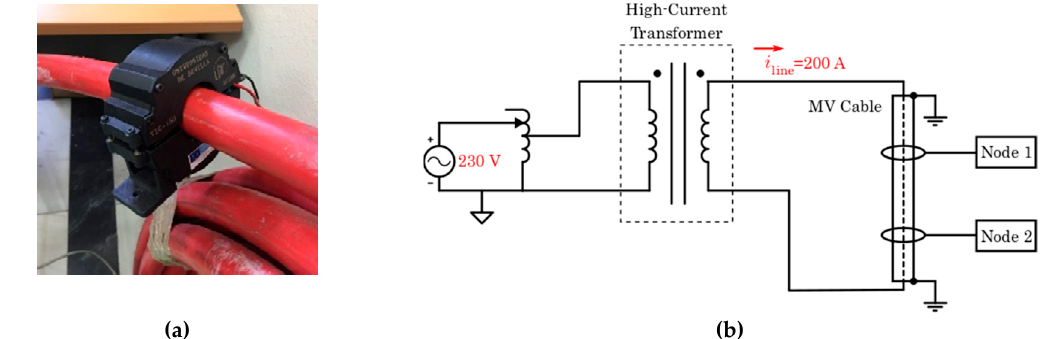
Figure 18. (a) Coupled transformer; and (b) high-current transformer. Figure 18. ( a ) Coupled transformer; and ( b ) high-current